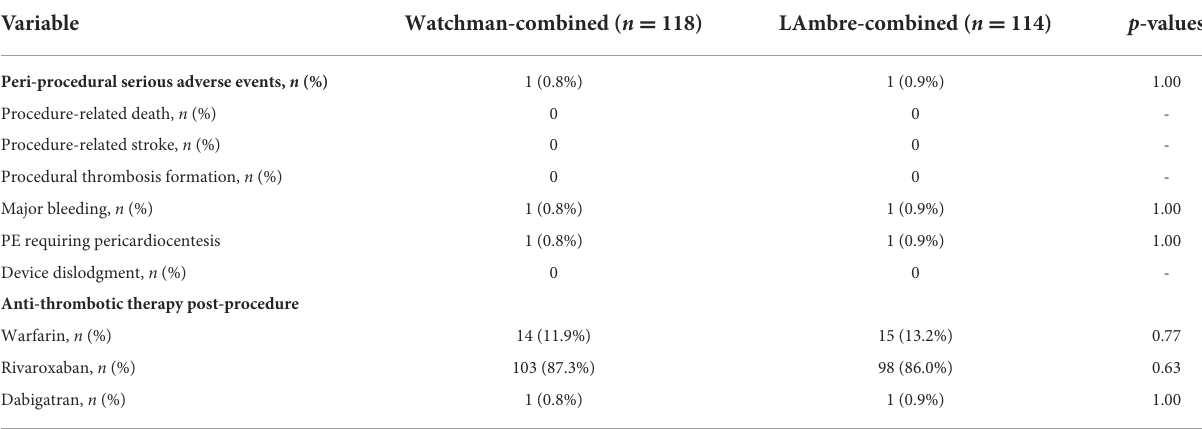
TABLE 3 Peri-procedural adverse events and antithrombotic